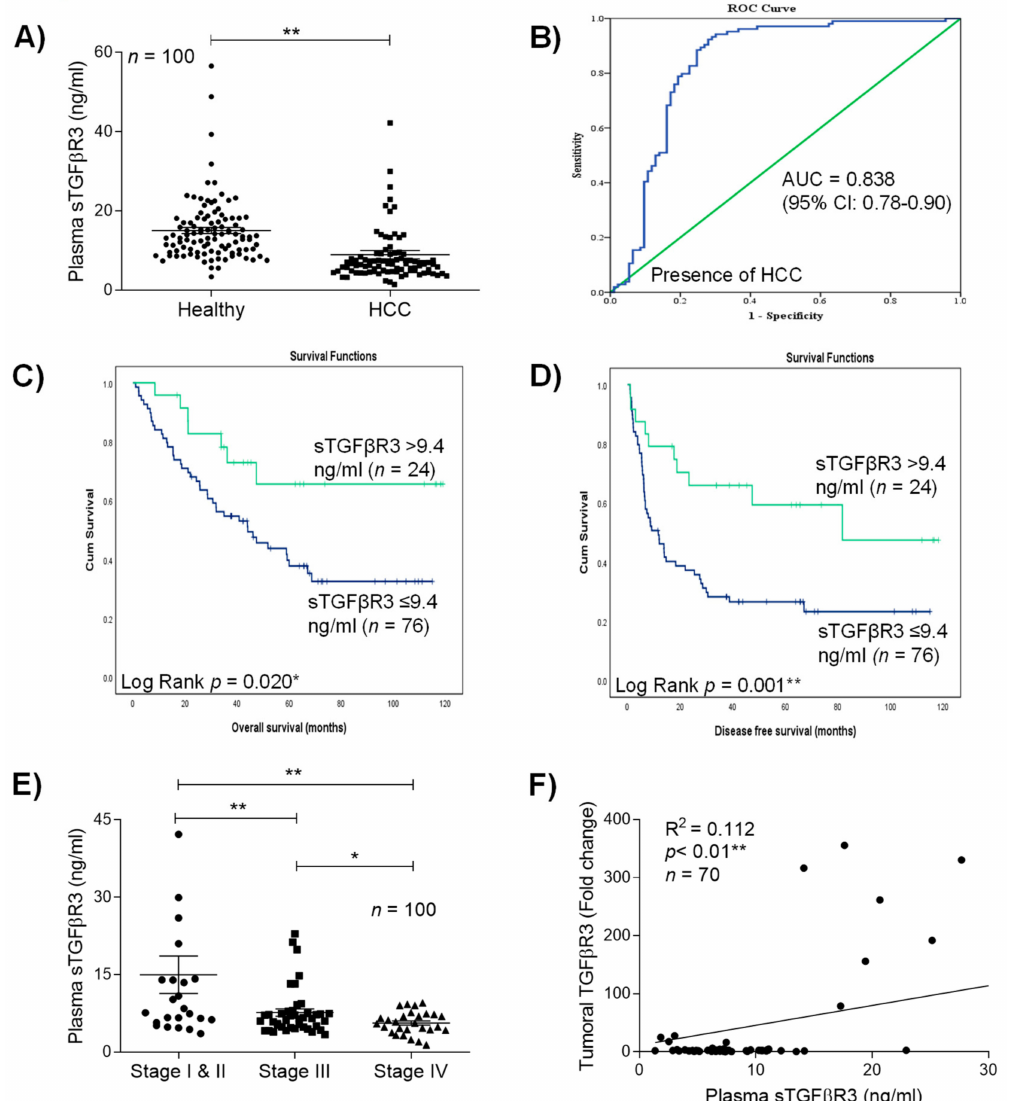
Figure 2. Clinical significances of sTGF β R3 down-regulation in HCC plasma. ( A ) ELISA analysis of plasma sTGF β R3 in patients. ( B ) Receiver operation characteristics (ROC) curve analysis. The clinical values were accessed by differentiation of 100 preoperative HCC patients from 100 healthy individuals. The AUC was 0.838 ± 0.032 ( p < 0.01). ( C , D ) Kaplan– Meier analysis of overall survival and disease-free survival in HCC patients associated with the plasma level of sTGF β R3. ( E ) Level of sTGF β R3 in patients with different tumor stage. ( F ) Correlation between tumoral TGF β R3 and plasma sTGF β R3. * p < 0.05, ** p < 0.01. Error bar indicated SEM. (Unpaired t -test for Figure 2A, E) (Chi-square test for Figure 2F) (Log rank test for Figure